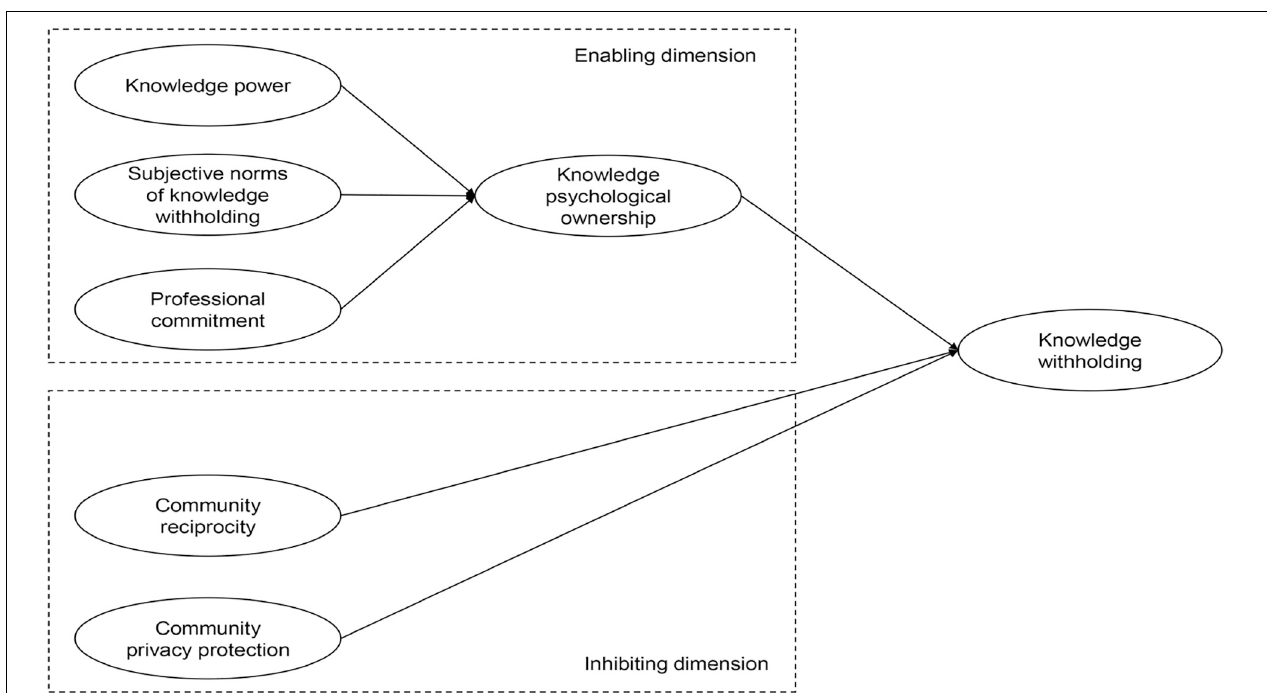
FIGURE 1 | Influencing factor model of user knowledge withholding in virtual academic